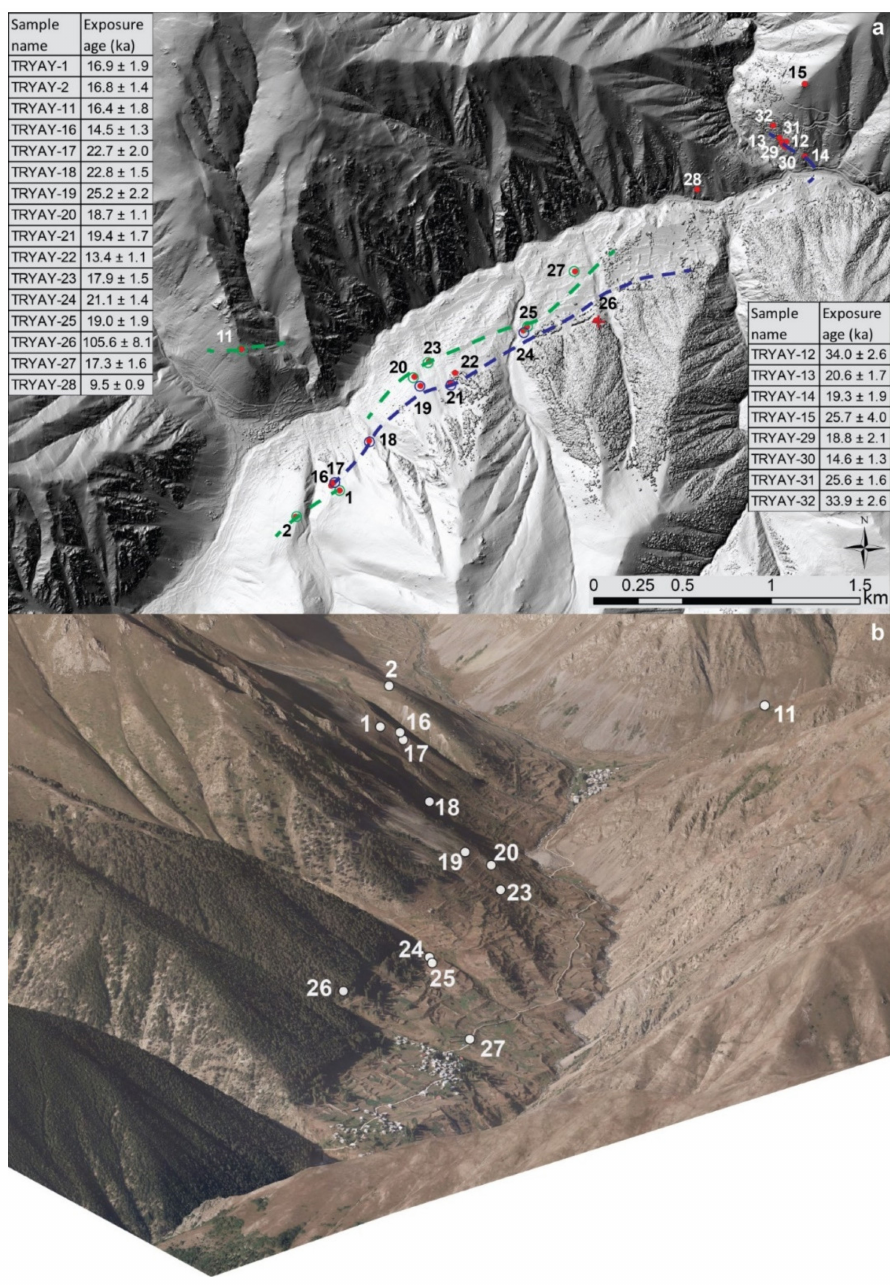
Figure 4. ( a ) Barhal Valley sample locations with summary table of cosmogenic 36 Cl ages. Recon- structed right lateral ice margins: lower green line = 18.3 ± 1.7 ka advance, blue line = 22.2 ± 2.6 ka advance. ( b ) Barhal Valley sample locations between Yaylalar (bottom of the map) and Olgunlar (at the valley confluence), as seen in digital relief